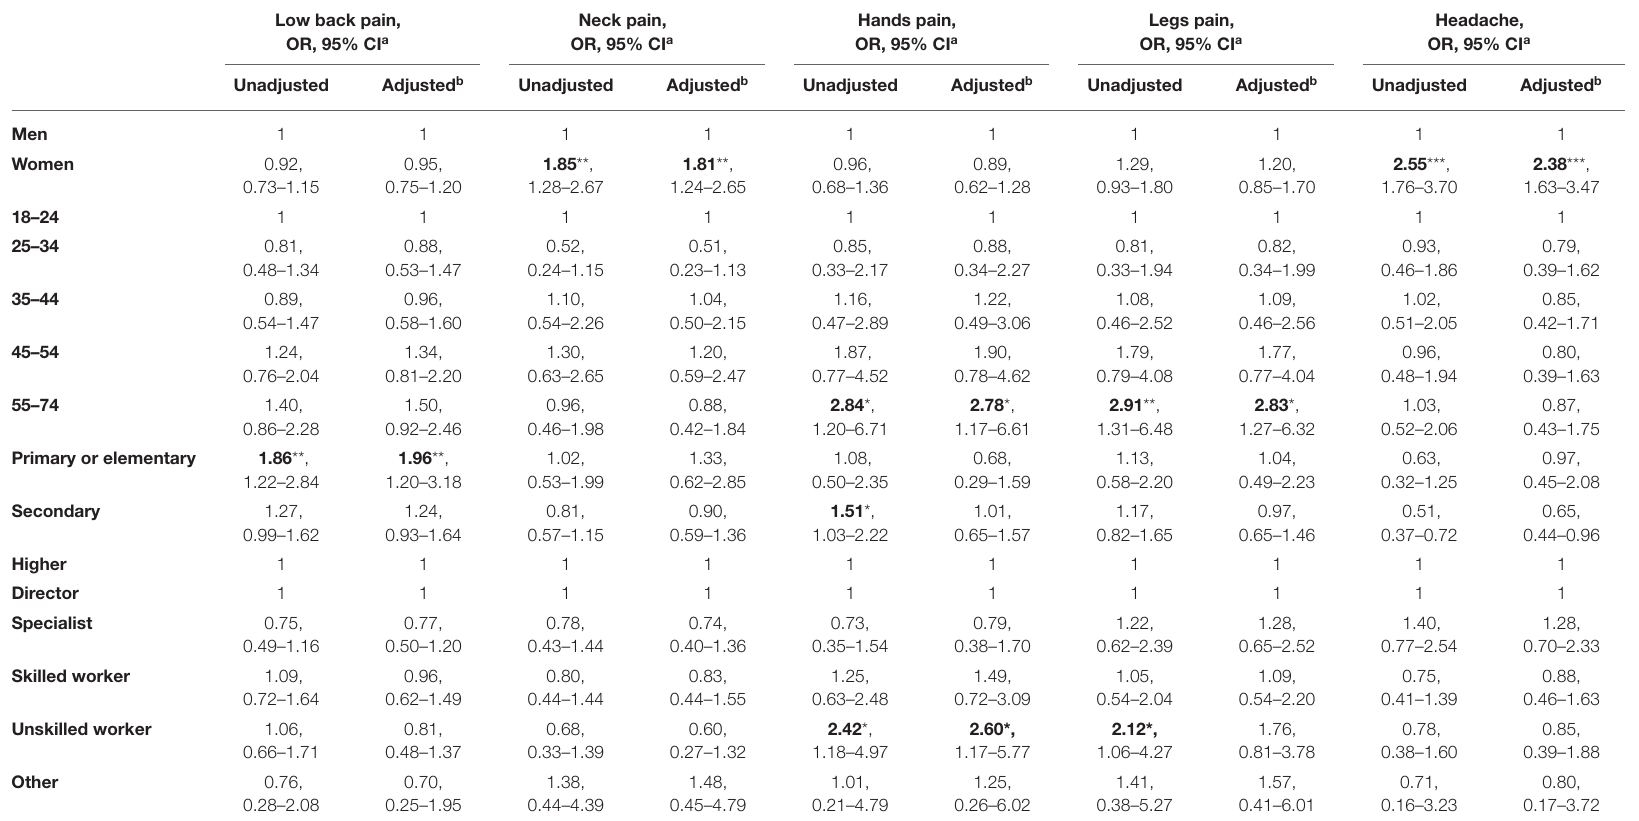
TABLE 5 | Odds of different pain locations during the last year and association with sociodemographic factors. Low back pain, OR, 95% CI